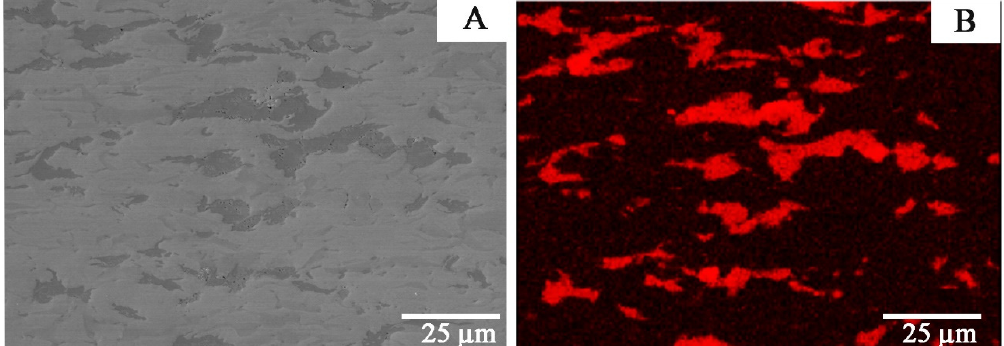
Figure 3. The Zr-2.5Cu microstructure for the material obtained by the extrusion method is presented (longitudinal section): ( A ) SEM microstructure; ( B ) Cu distribution for this microstructure.